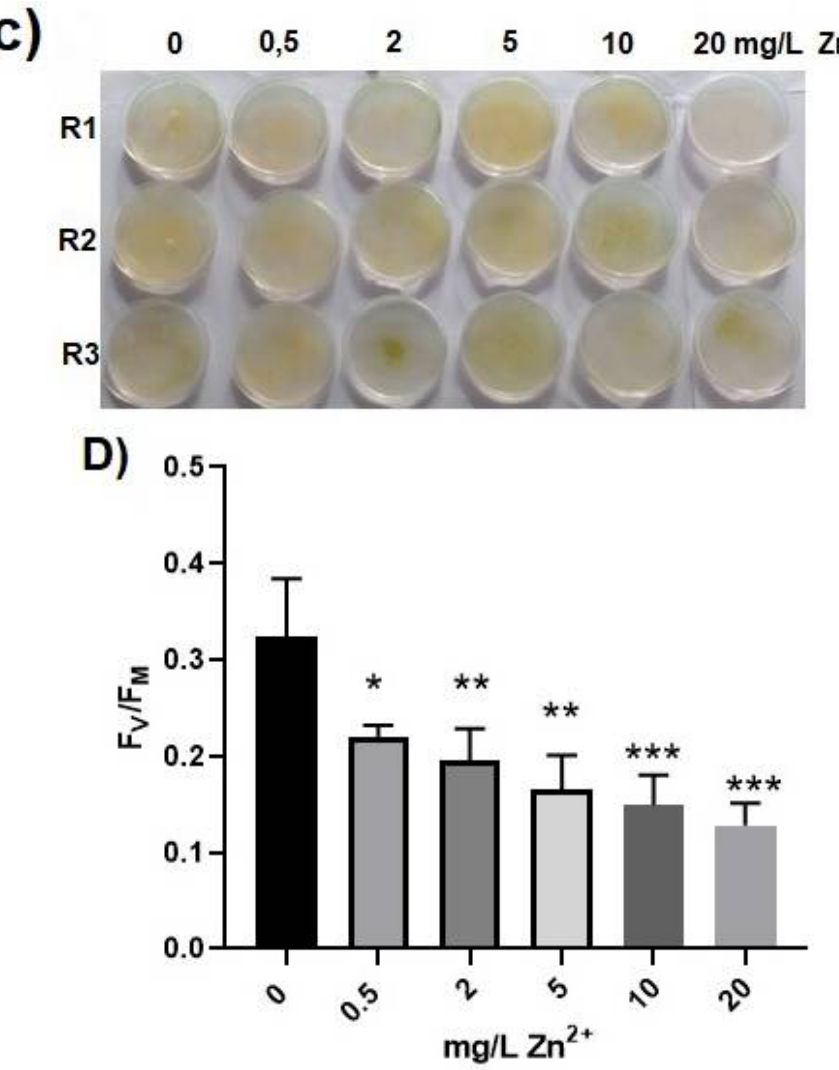
Figure 1. Observation of the microalgae Tetraselmis marina AC16-MESO. ( A , B ) Photographs of microalgal cells through confocal microscopy. ( C ) Petri dishes with bacteriological agar medium at different concentrations of Zn 2+ after 68 days. ( D ) Maximum quantum yield (F V /F M ) in cultures of T. marina AC16 MESO exposed to different Zn 2+ treatments for 68 days. Bars indicate the standard error (SE), *** p < 0.001, ** p < 0.01, * p < 0.05 with respect to 0 mg/L Zn2+ (Tukey’s multiple comparison